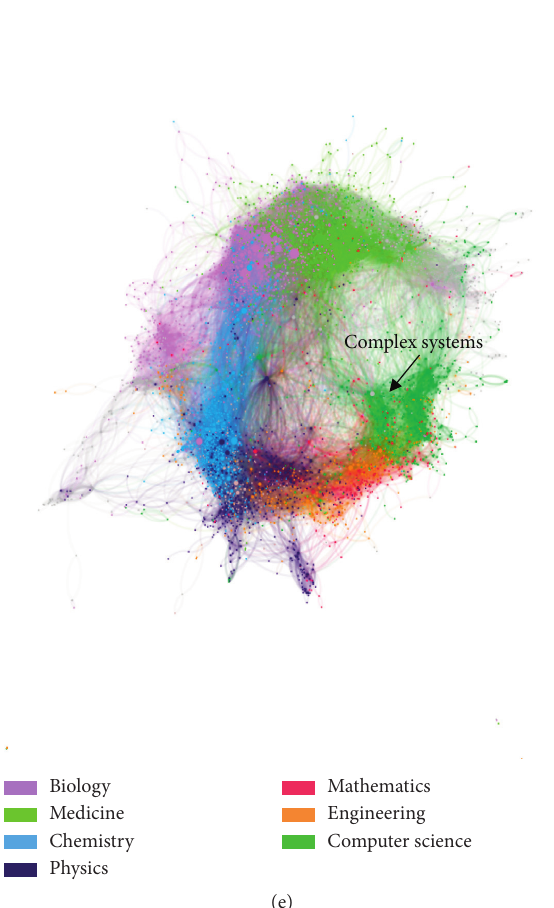
Figure 1: The knowledge production and citation networks. (a) The yearly number of publications as a function of time from 1960 to 2018, for the whole Microsoft Academic Graph (green) and the field of complex systems (red) and its related fields (blue). We fit each growth pattern using an exponential function, shown in dashed lines. (b) The fraction of yearly number of papers of complex system relative to the whole MAG, together with a linear fit. Field citation networks in the (c) 1980s, (d) 1990s, and (e) 2000s, with nodes being MAG level-2 fields and links of the citation/reference relationships between two fields. In order to eliminate insignificant links, we applied a backbone extraction method. Different colors represent ancestor fields of these level-2 fields. We also annotate the field of complex system in the citation